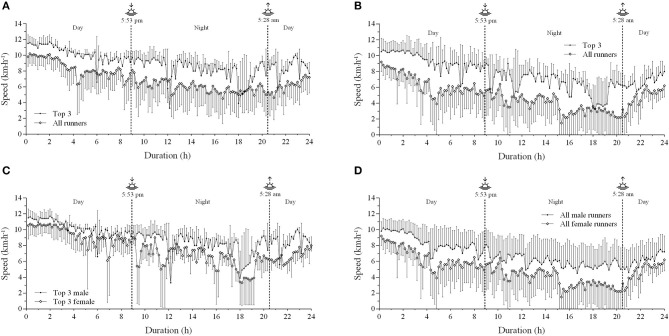
Mean running speed in each 10-min interval of the 24-h ultramarathon. (A) top 3 male and all male runners; (B) top 3 female and all female runners; (C) top 3 male and top 3 female runners and (D) all male and all female runners; Top 3, the overall 3 best runners.